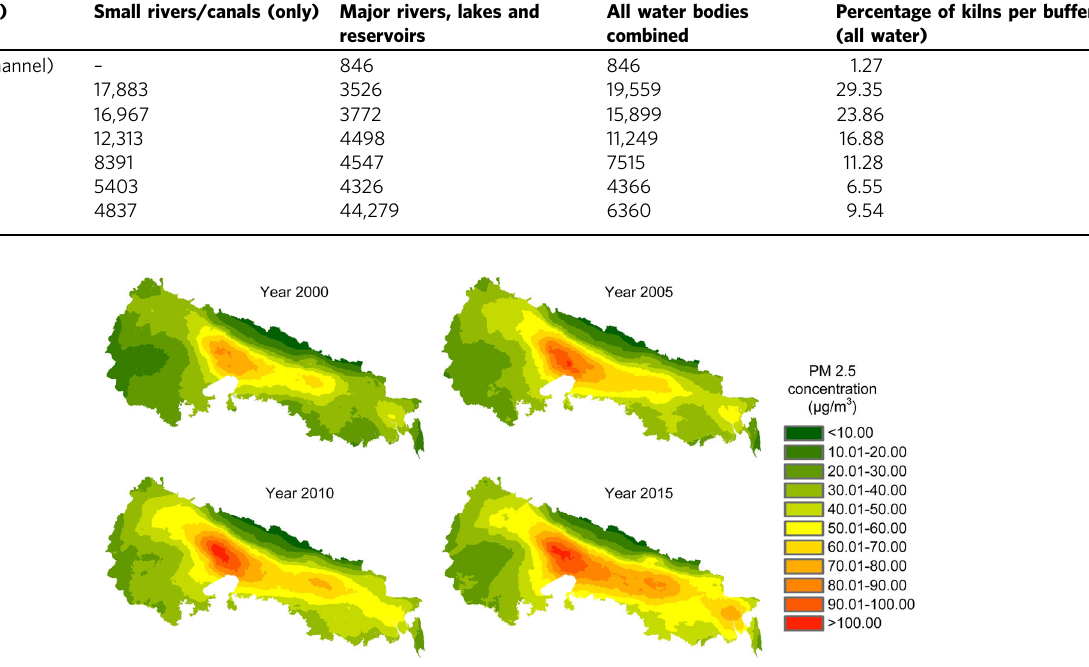
Fig. 7 Global Annual PM2.5 data (micrograms per cubic meter ( μ g/m 3 ) of ground-level fi ne particulate matter, with dust and sea-salt removed) distribution across the Brick Belt for 4 epochs of time (2000, 2005, 2010 and 2015) at a spatial resolution of 0.01° (data source: https://sedac. ciesin.columbia.edu/data/set/sdei-global-annual-gwr-pm2-5-modis-misr-seawifs-aod). Concentrations of PM2.5 are mapped in classes of 10 ug/m 3 as illustrated by the